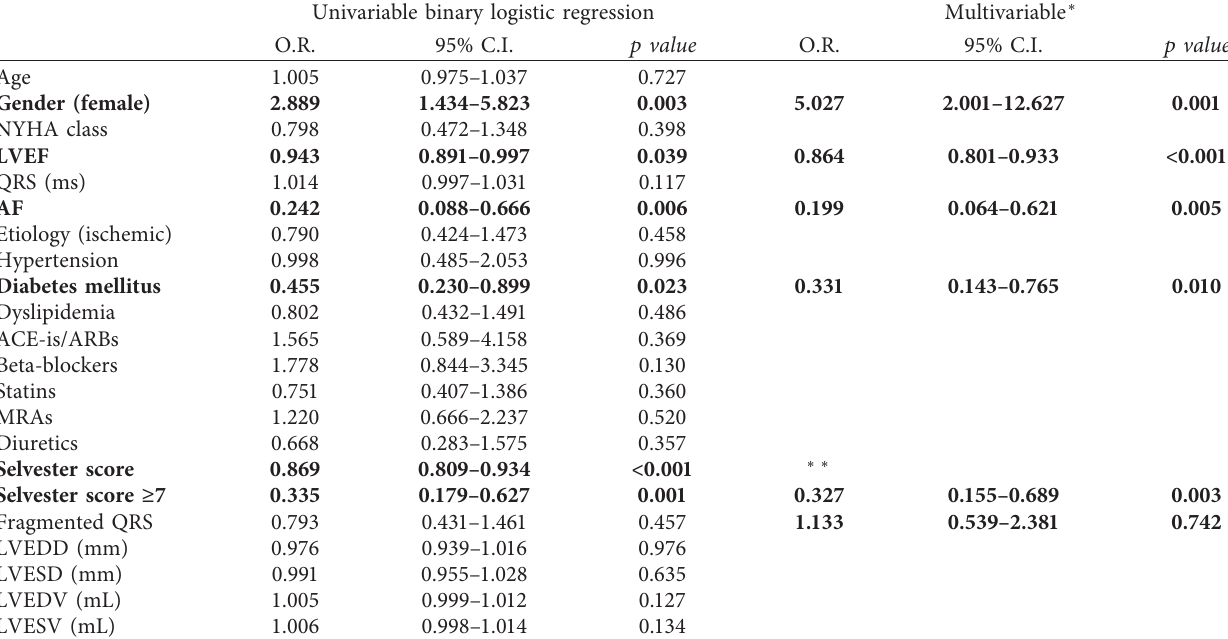
Table 4: Selvester score and fragmented QRS univariable and multivariable analysis for the primary endpoint (response to CRT). Univariable binary logistic regression Multivariable ∗